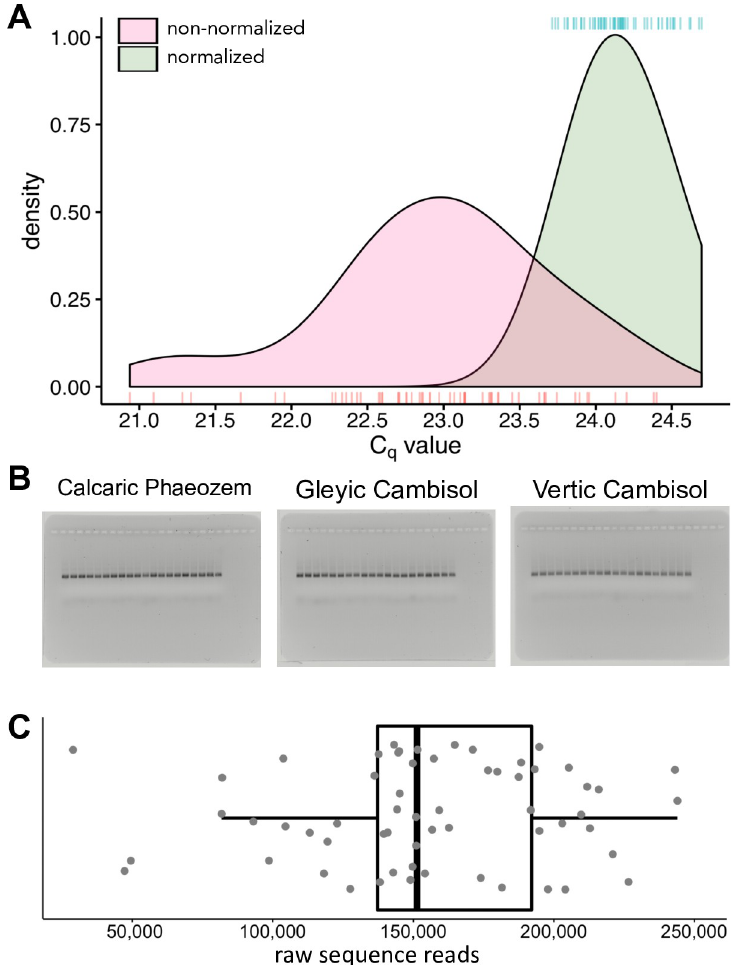
Fig 2. Kernel density estimation of the quantification cycle (C q ) values for non-normalised and normalised samples (prior to library preparation) ( A ), prepared libraries normalized by photo densitometry ( B ), and the distribution of the raw sequence reads per library ( C ). Individual C q values are plotted as marks below the density curves for non- normalised and above for normalised samples; curves were smoothened using a bandwidth of 0.3 ( A ). The box indicates the q25, q50, and q75, whiskers range from q25 or q75 to 1.5 × the interquartile range, dots represent individual data points ( C ). n = 60